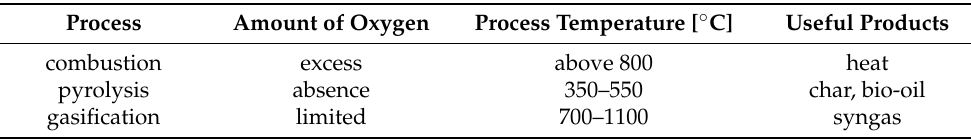
Table 1. Characteristics of thermochemical conversion pathways 1